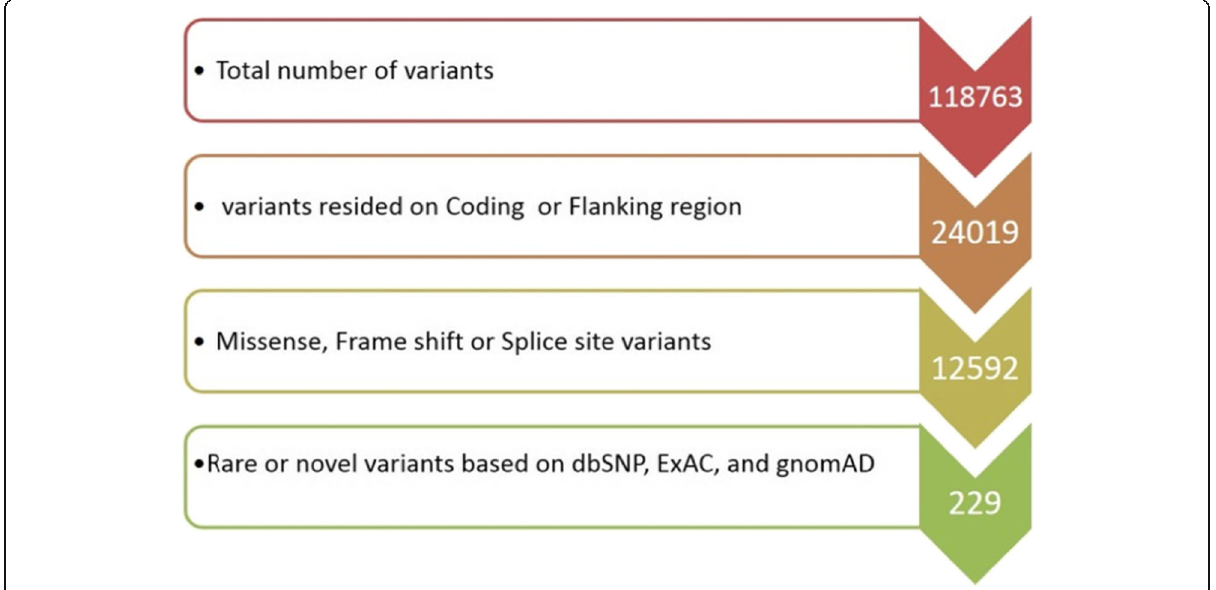
Fig. 2 Schematic flow chart of the filtering of causative variants in this study